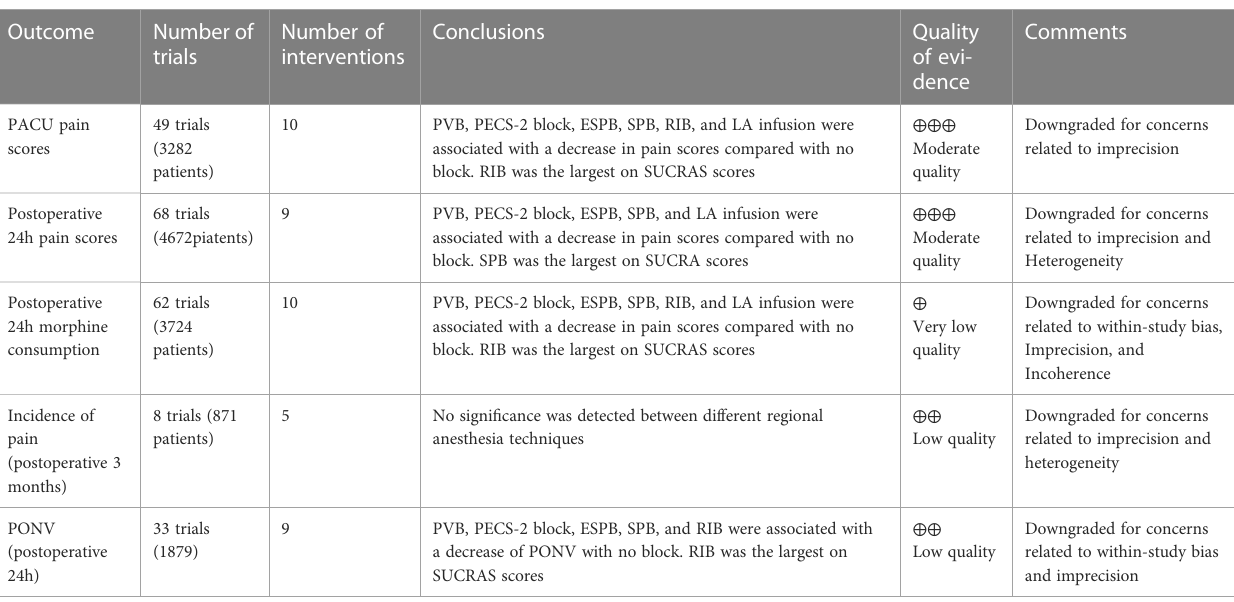
TABLE 1 The GRADE quality of evidence assessment for the outcomes in results of network meta-analysis.